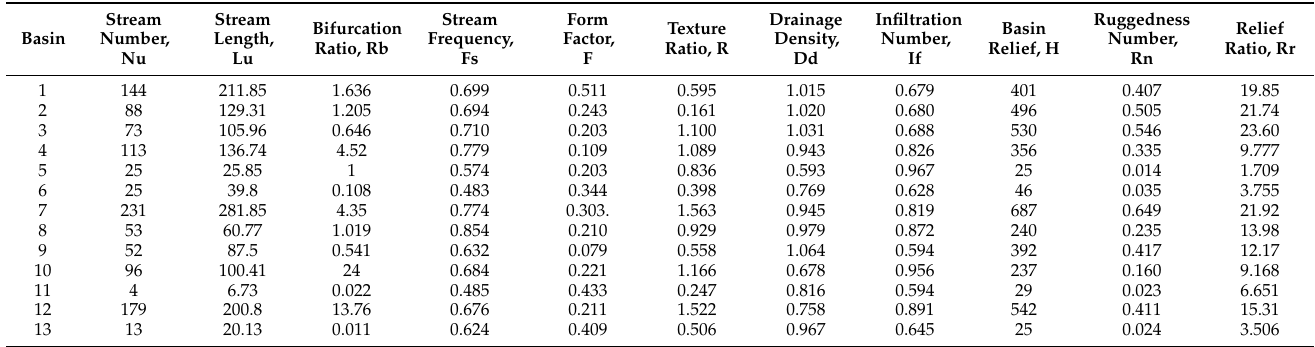
Table 5. Extracted values of all the morphometric parameters for each